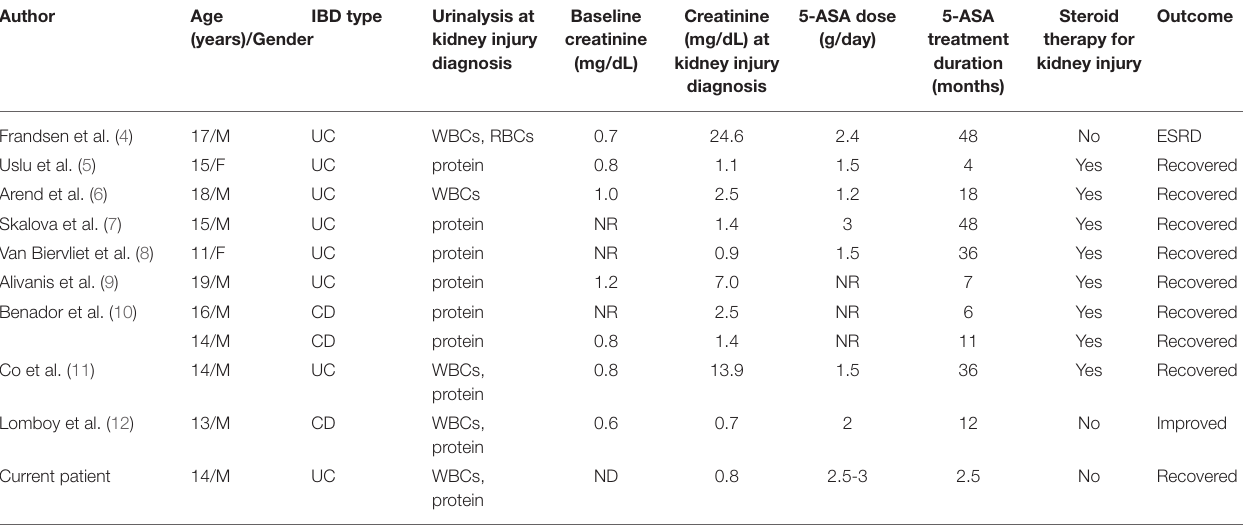
TABLE 1 | Summary of mesalazine-induced kidney injury in pediatric patients with inflammatory bowel disease (IBD).